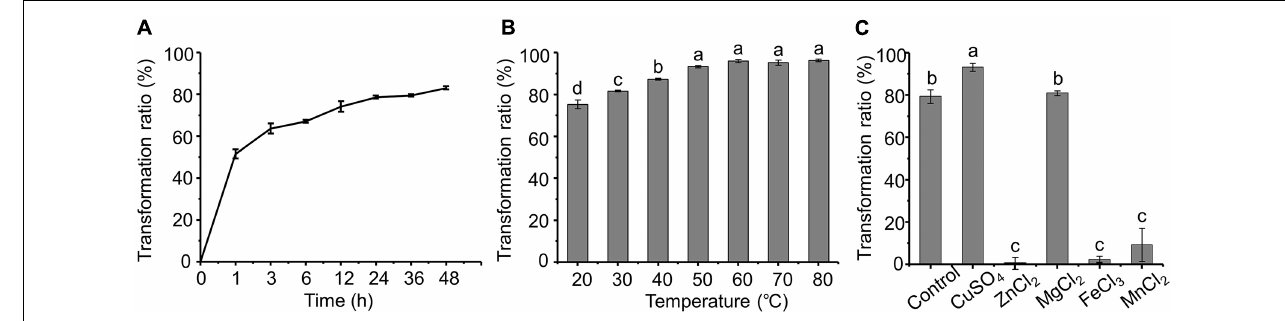
FIGURE 4 | Effect of time, temperature and metal ions on aflatoxin B 1 (AFB 1 ) transformation by supernatant of m29. (A) Effect of incubation time; (B) effect of temperature; (C) effect of metal ions. Values expressed as mean ± SD, and different letters represent significant difference according to Tukey’s LSD test ( p < 0.05).